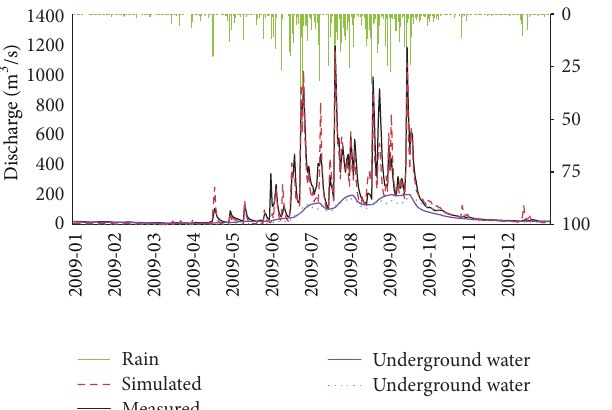
Figure 8: XAJ model validation phase (2009). Measured and simu- lated discharge, the groundwater runoff separated from the hydro- graph and calculated by Xin’anjiang model, and catchment average rainfall time series.